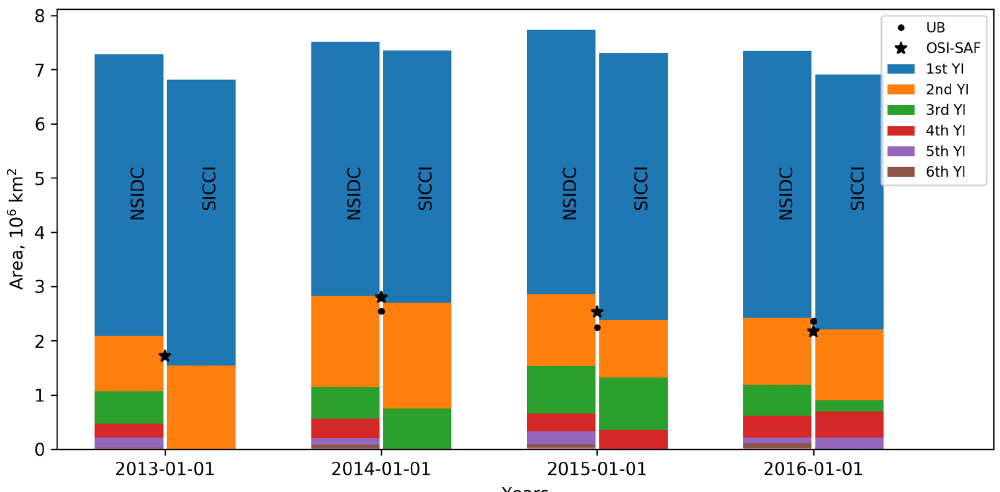
Figure 9. Interannual dynamics of area of sea ice age fractions (bars) and multi-year ice area (dots) derived from NSIDC product (left bars), from NERSC product (right bars), from UB product (black dots) and from OSI SAF (black stars).